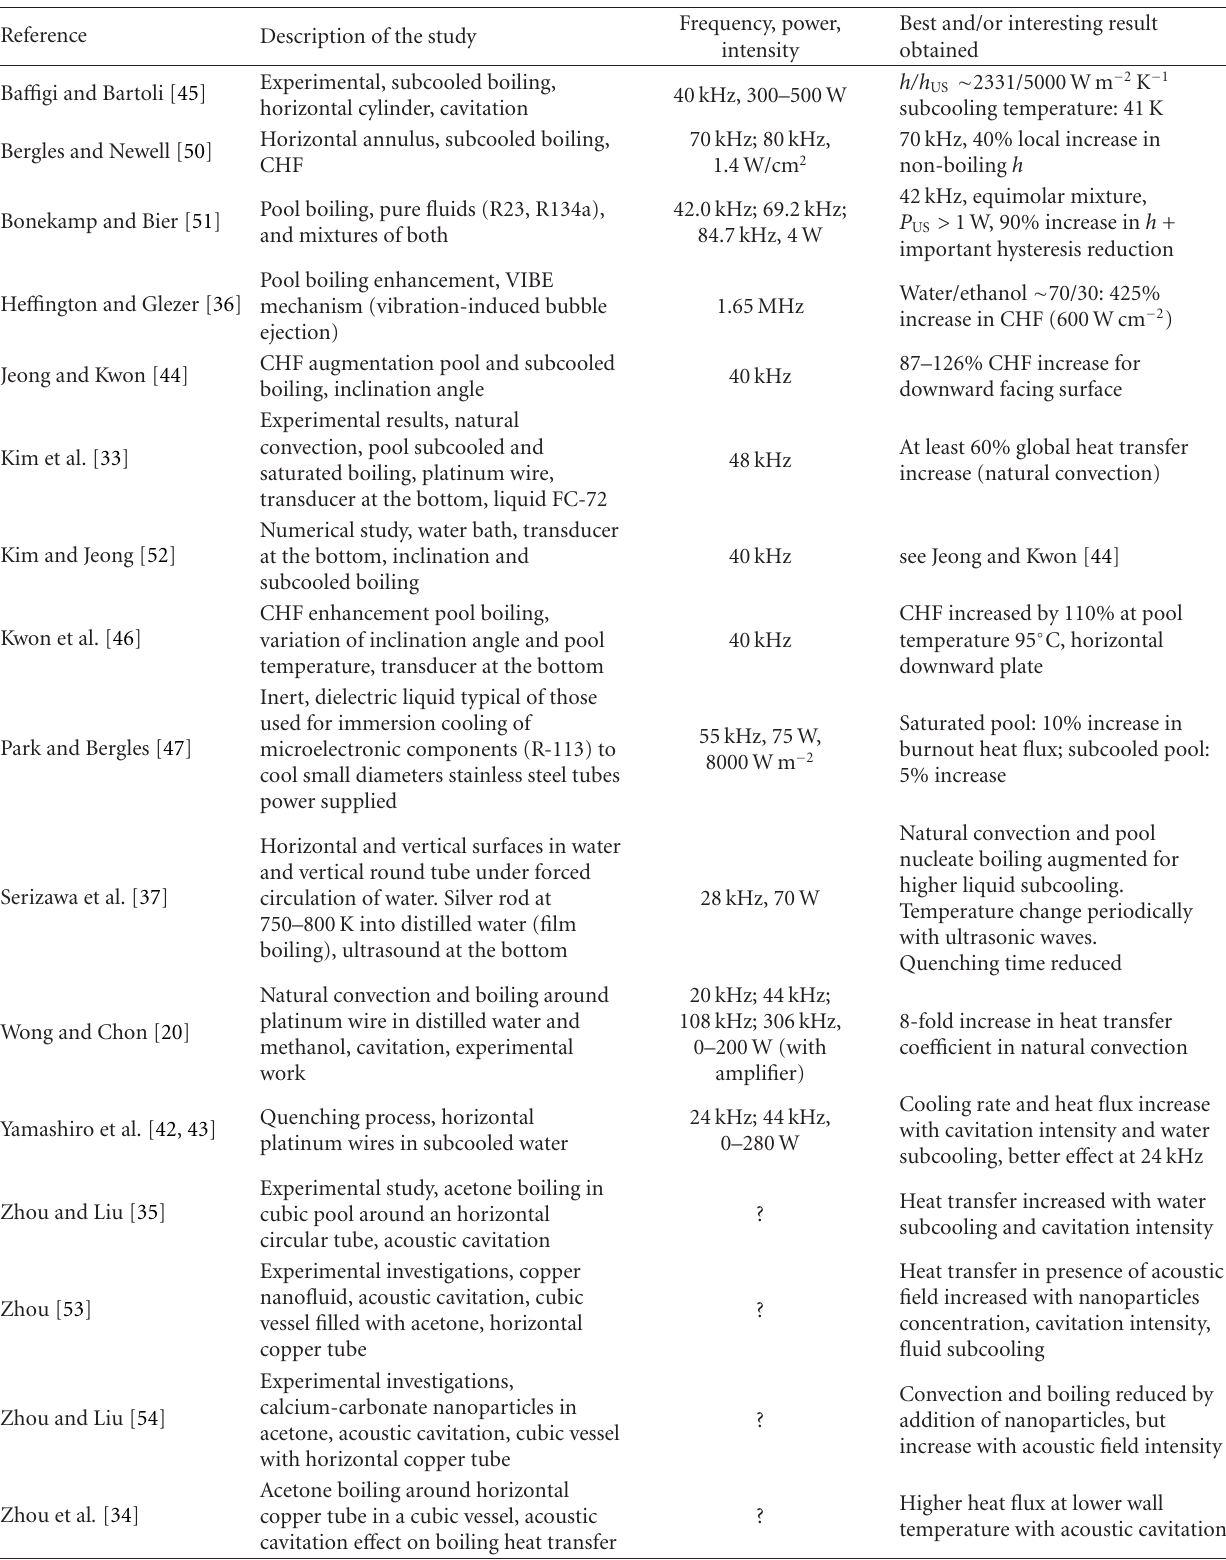
Table 2: Summary table of boiling heat transfer